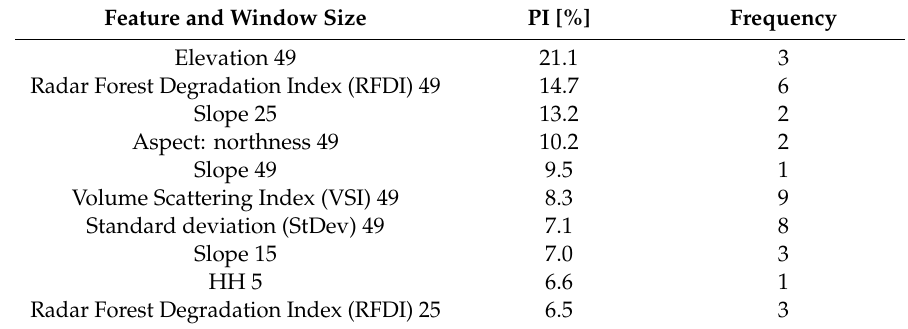
Table 6. Features with the highest average permutation importance throughout all classifications.